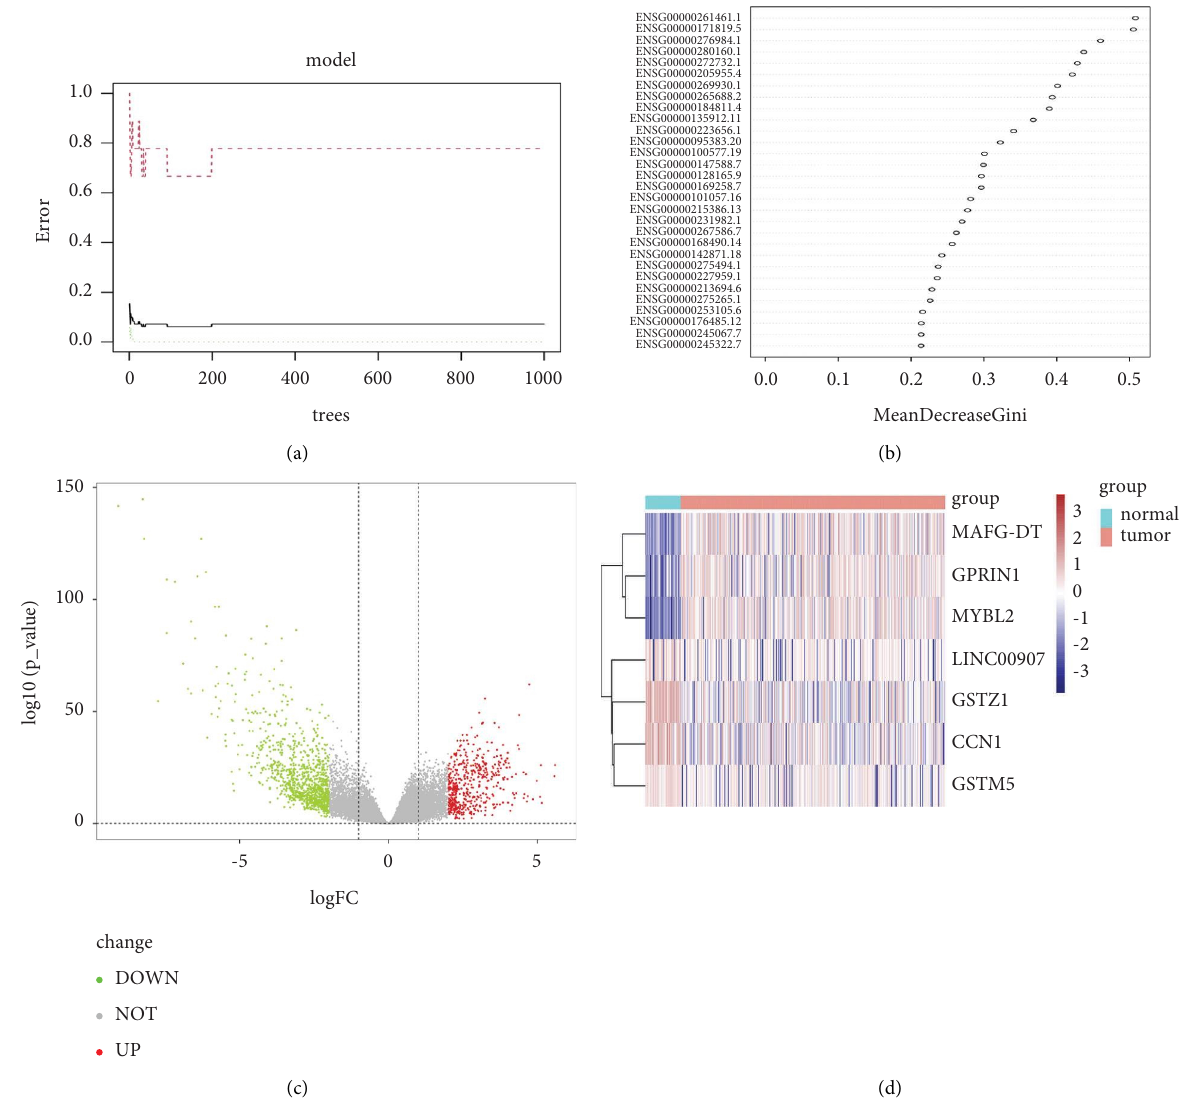
Figure 2: Identifcation of important DEGs: (a) the efect of the number of decision trees on the error rate. Te X -axis represents the number of decision trees, and the Y -axis represents the error rate. When the number of decision trees is about 400, the error rate is relatively stable; (b) results of the Gini coefcient method in random forests. Te X -axis represents genetic variables and the Y -axis represents the importance index; (c) the volcano diagram; (d) the heatmap